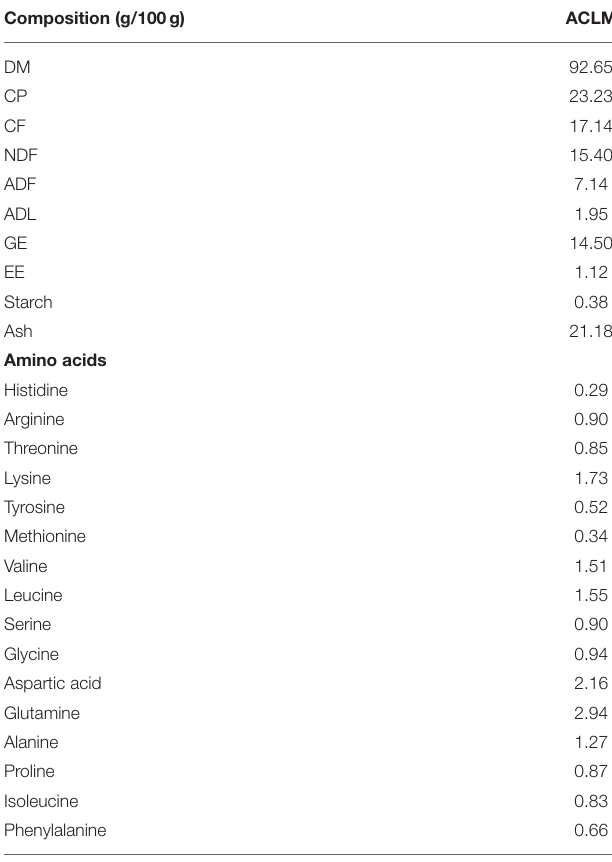
TABLE 1 | Proximate composition (g/100g), gross energy (kcal/g), and amino acids composition (%) of Amaranthus cruentus leaf meal (ACLM). Composition (g/100g)